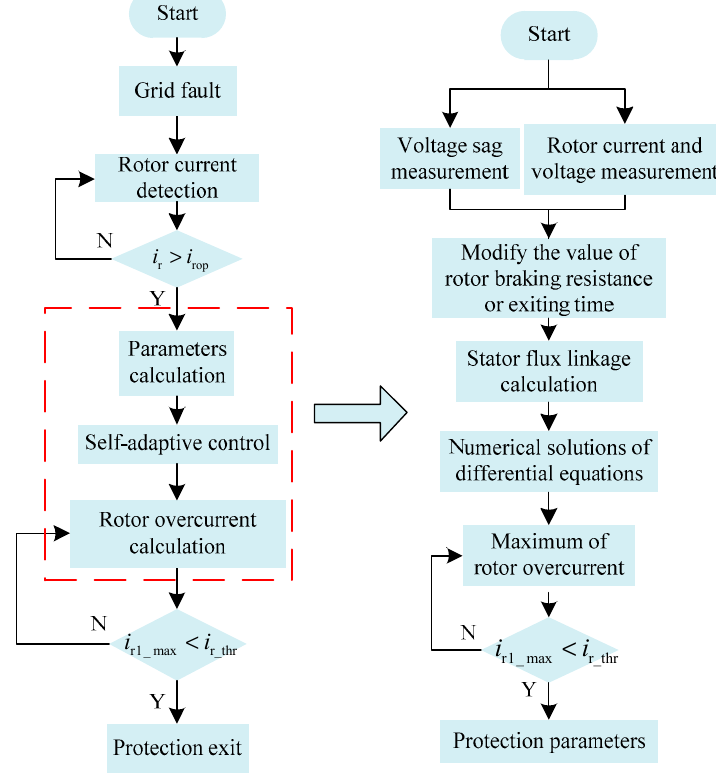
Figure 11. Flow diagram of the self-adaptive control.